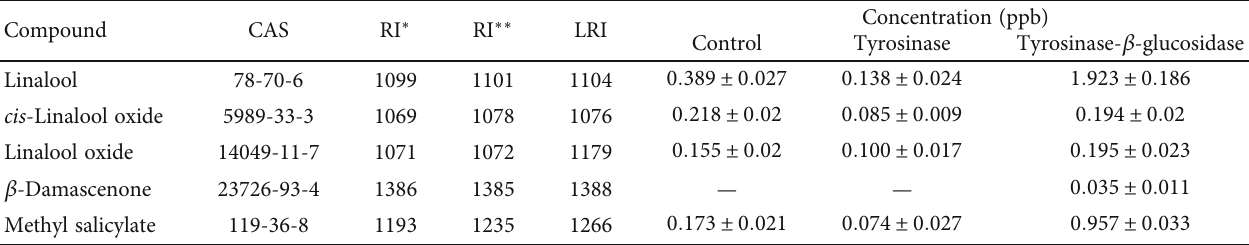
Table 4: The volatile compound of the treated and untreated tea extract with β -glucosidase.